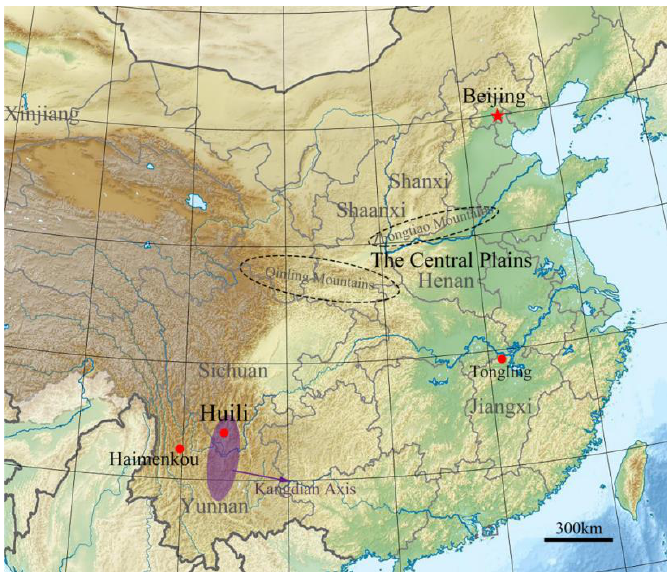
Figure 1. The geographical location of Huili County and other places mentioned in this